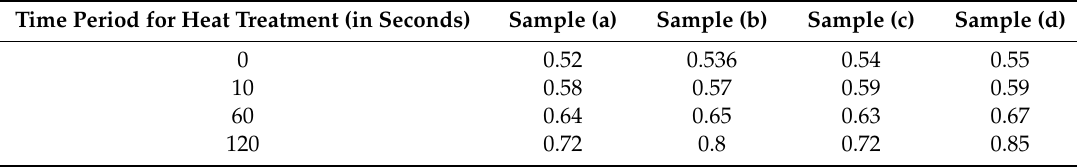
Figure 9. Mean emissivity values and standard deviation bars for porcine skin samples (obtained from di ff erent animals) before and after di ff erent applications of localized heat treatments. Samples a, b, c, and d represent normal skin; a1, b1, c1, and d1 represent skin with burns after 10 s of heat treatment (first degree burn); a2, b2, c2, and d2 represent skin with burns after 60 s of extra heat treatment (second degree burn); a3, b3, c3, and d3 represent skin with burns after 120 s of extra heat treatment (third degree burn). Table 2. Mean emissivities for porcine skin after di ff erent applications of heat treatments. Time Period for Heat Treatment (in